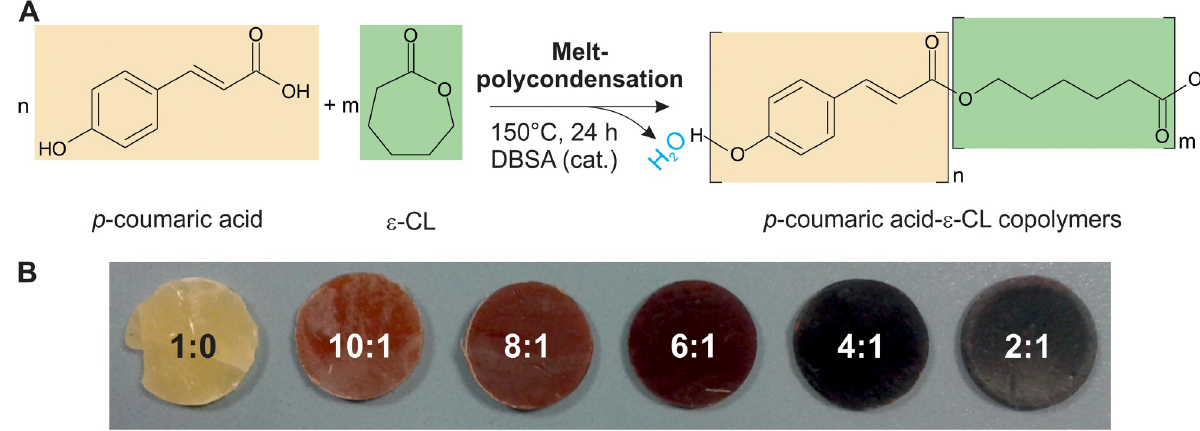
Fig 1. Scheme of synthesis and photographs of the biopolymers. (A) Polymerization reaction between ε -caprolactone and p -coumaric acid. ε -CL and PCA monomers and their corresponding repetitive units in the polyester have been highlighted in light green and light orange, respectively. (B) Photographs of the ε -caprolactone- p -coumaric acid copolymer